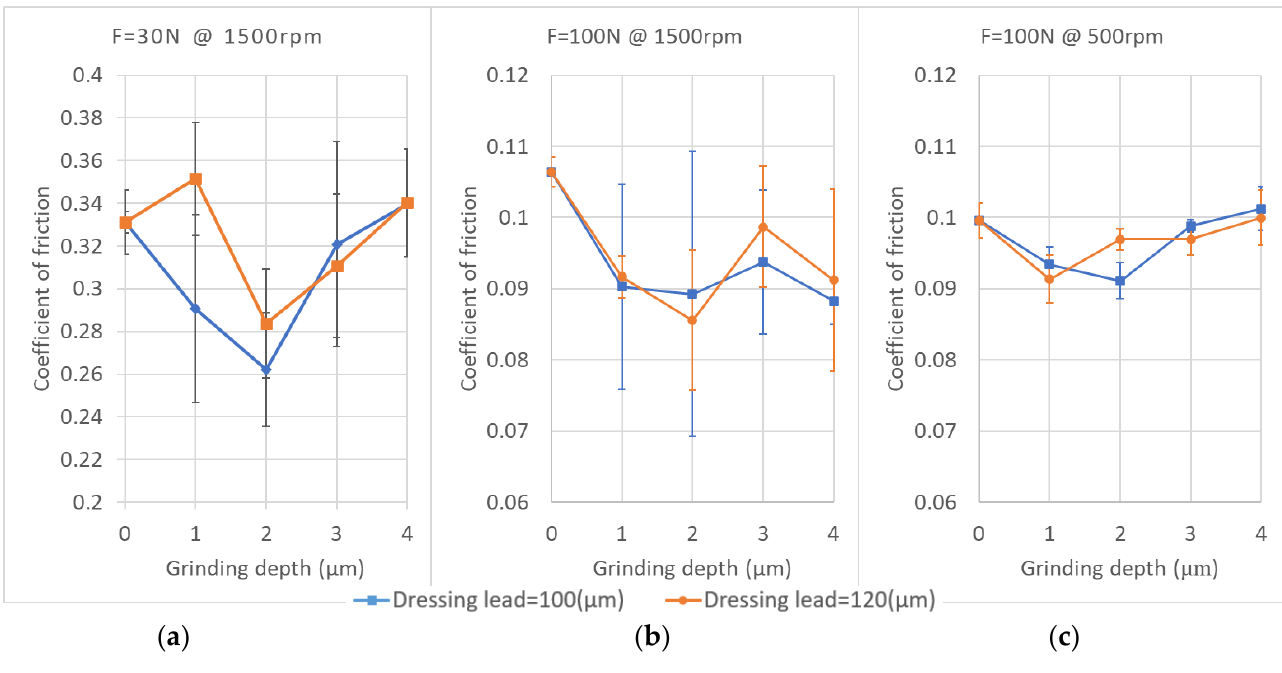
Figure 7. Effect of grinding parameter on COF for different test conditions. ( a ) Test A. ( b ) Test B. ( c ) Test C.